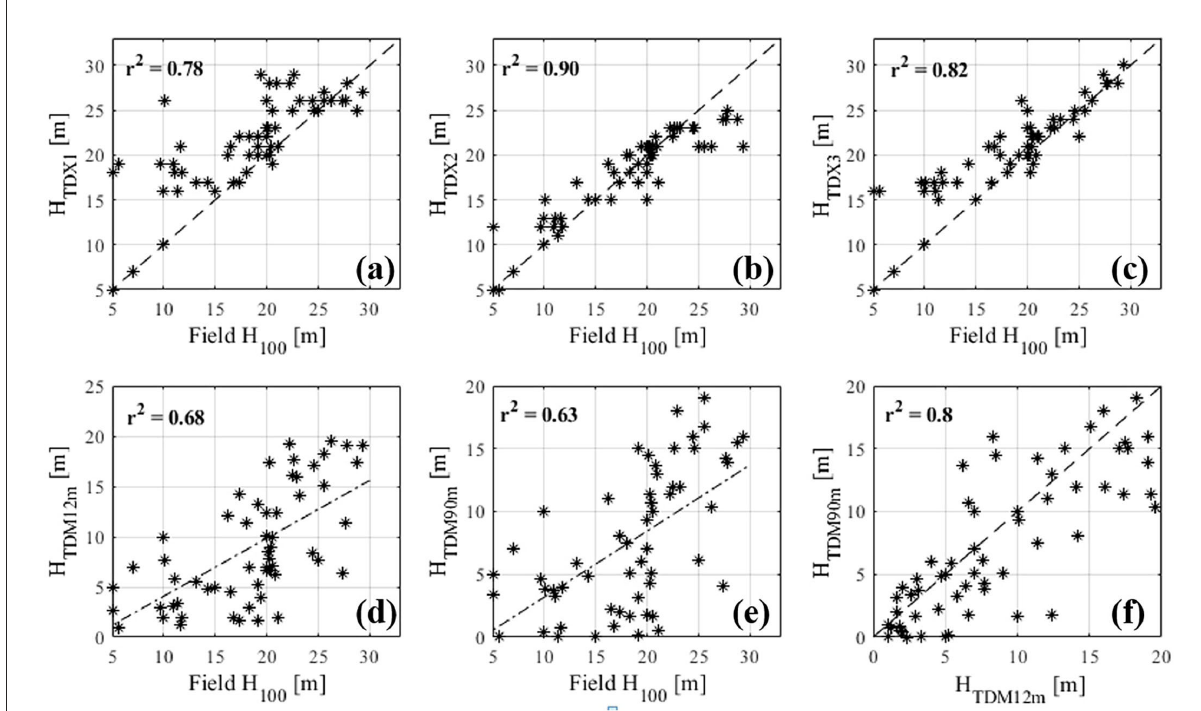
FIGURE3 Height validation plots: The field estimated forest stand height ( H 100 ) is plotted against PolInSAR estimated forest height for the three PolInSAR acquisitions (a–c) , and vegetation bias height estimated using TanDEM-X 12 m DEM (d) and TanDEM-X 90 m DEM (e) . In (f) the vegetation bias estimated from TanDEM-X 12 m DEM and TanDEM-X 90 m DEM are cross-validated. r 2 represents the coefficient of determination. The dotted line is the linear-fit